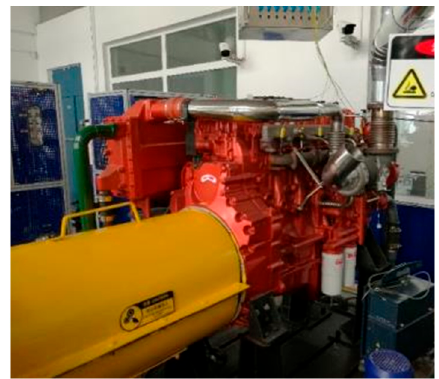
Figure 2. Test bench of the tested YUCHAI 6K engine.